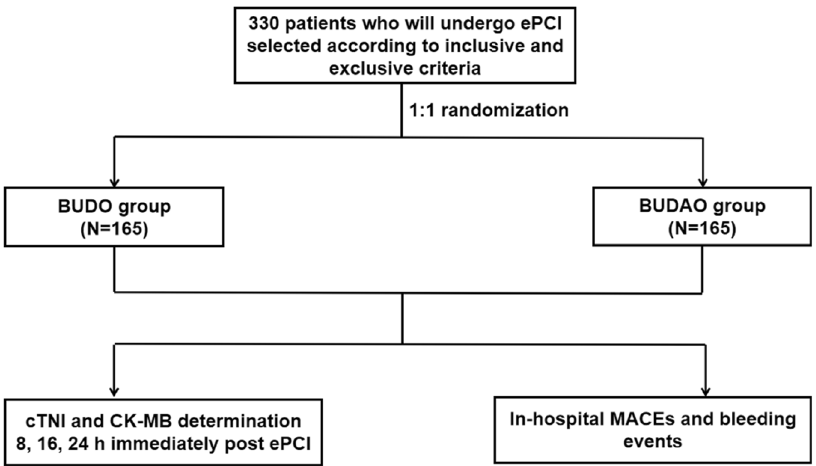
Figure 1. Flowchart of this study. ePCI, Elective percutaneous coronary intervention; cTnI, Cardiac troponin I; CK-MB, Creatine